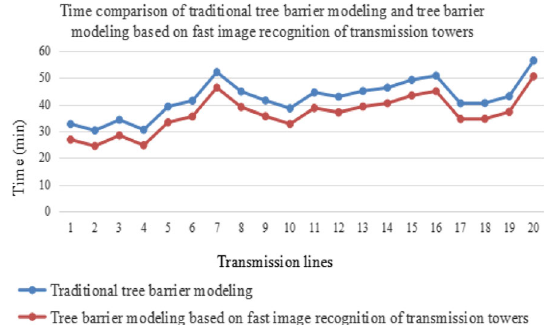
Fig. 9 Times of traditional and proposed tree barrier modeling methods. X axial is the number of the case study and y axial is the time it uses close to the transmission lines but not to reach the general defect level.